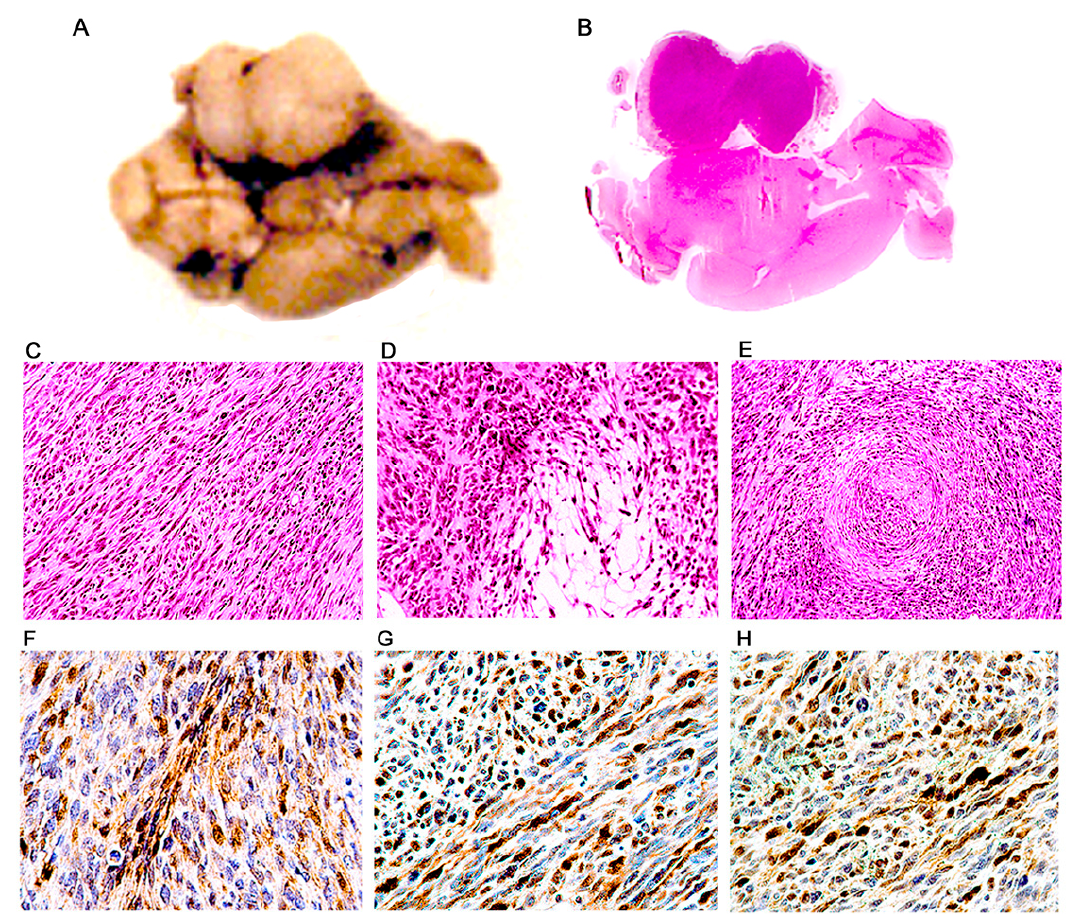
Figure 6. Malignant peripheral nerve sheath tumors (MPNSTs); histological and immunohistochemical characterization. Ventral surface of a transgenic mouse brain showing a large, well ‐ circumscribed, solid, homogeneous mass located in the ponto ‐ cerebellar angle (Panel ( A )). A full montage demonstrates that the tumor is extra ‐ axial and located in the place of the vestibulocochlear nerve (Panel ( B )). Histologically, tumors are composed of numerous, tightly packed, spindle cells, which form interlacing bundles and fascicles. A large number of mitotic figures are present (Panel ( C )). Dense cellularity areas (Antoni type A) alternate with areas where cells are loosely distributed (Antoni type B) (Panel ( D )). Also present are cellular whirling areas, which correspond to Verocay bodies (Panel ( E )). Immunohistochemistry for S ‐ 100 protein shows intense reactivity in the cytoplasm of neoplastic cells (Panel ( F )). T ‐ Antigen (Panel ( G )), and p53 (Panel ( H )) are expressed in the nuclei of neoplastic cell throughout the tumors. (Panels ( B )–( E ), hematoxylin & eosin all panels original magnifica ‐ tion ×400).